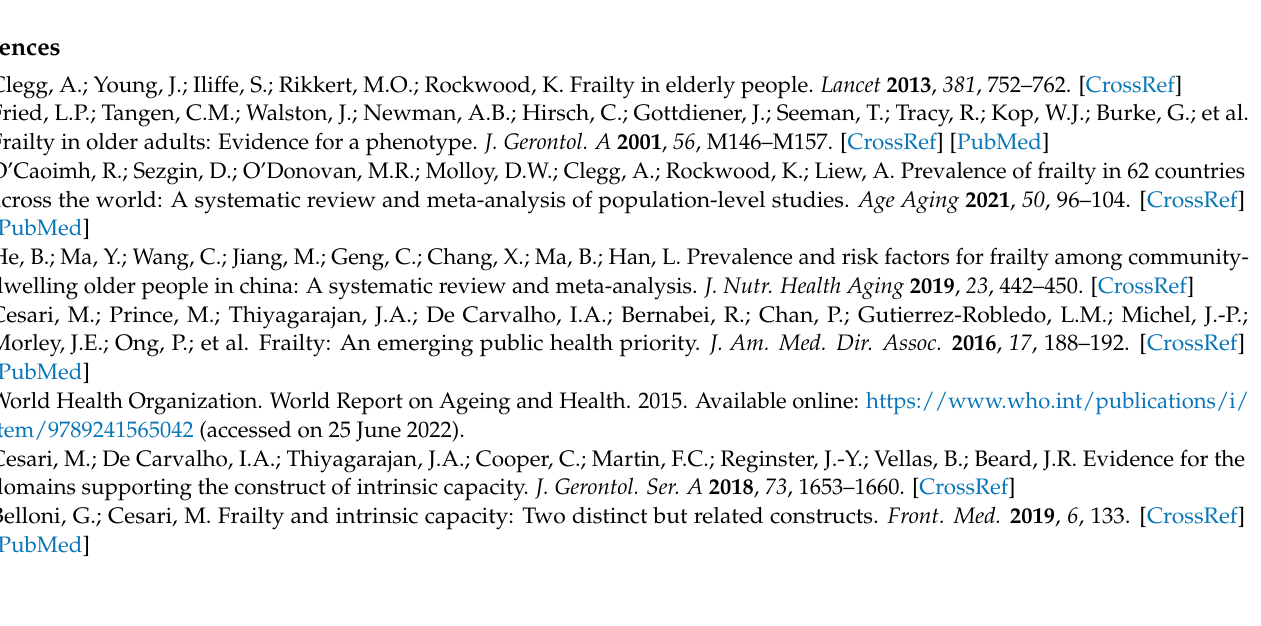
Table S4: The results of the CFSS-10 predicting one-year disability and all-cause mortality without adjusting for comorbidity (sample 2); Table S5: The results of the CFSS-8 predicting 1-year disability and all-cause mortality (sample 2); Table S6: The results of the CFSS-8 predicting 1-year ADL and IADL disability (sample 2); Table S7: The results of the CFSS-10 predicting 1-year ADL and IADL disability (sample 2); Figure S1: The distributions of the CFSS-20 (a), CFSS-8 (b), and CFSS-10 (c) score and prevalence of each item (d); Figure S2: The comparison of AUCs of the CFSS-20, CFSS-8 and CFSS-10 take the FRAIL, TFI and FI as criteria (sample